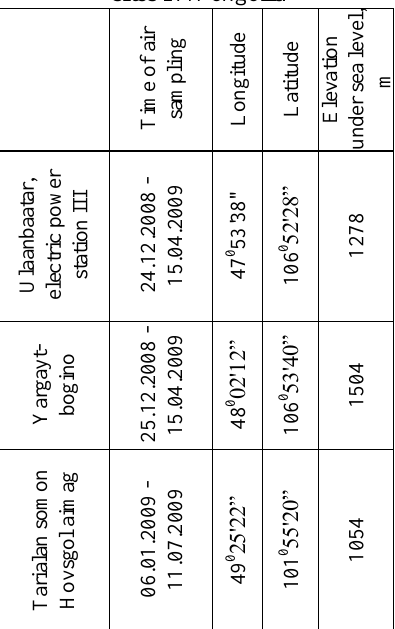
Table 1. The description of air sampling sites in Mongolia